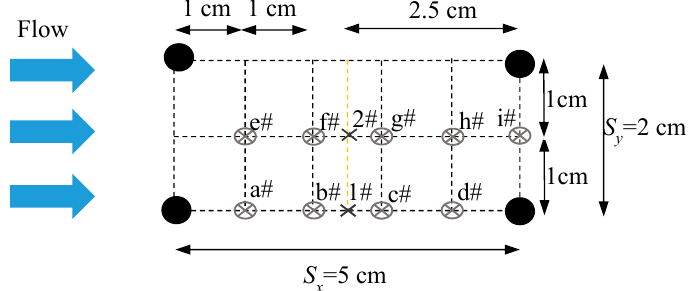
Figure 2. The arrangement of measurement points for analysis of spatial variations and representative locations of the flow field.